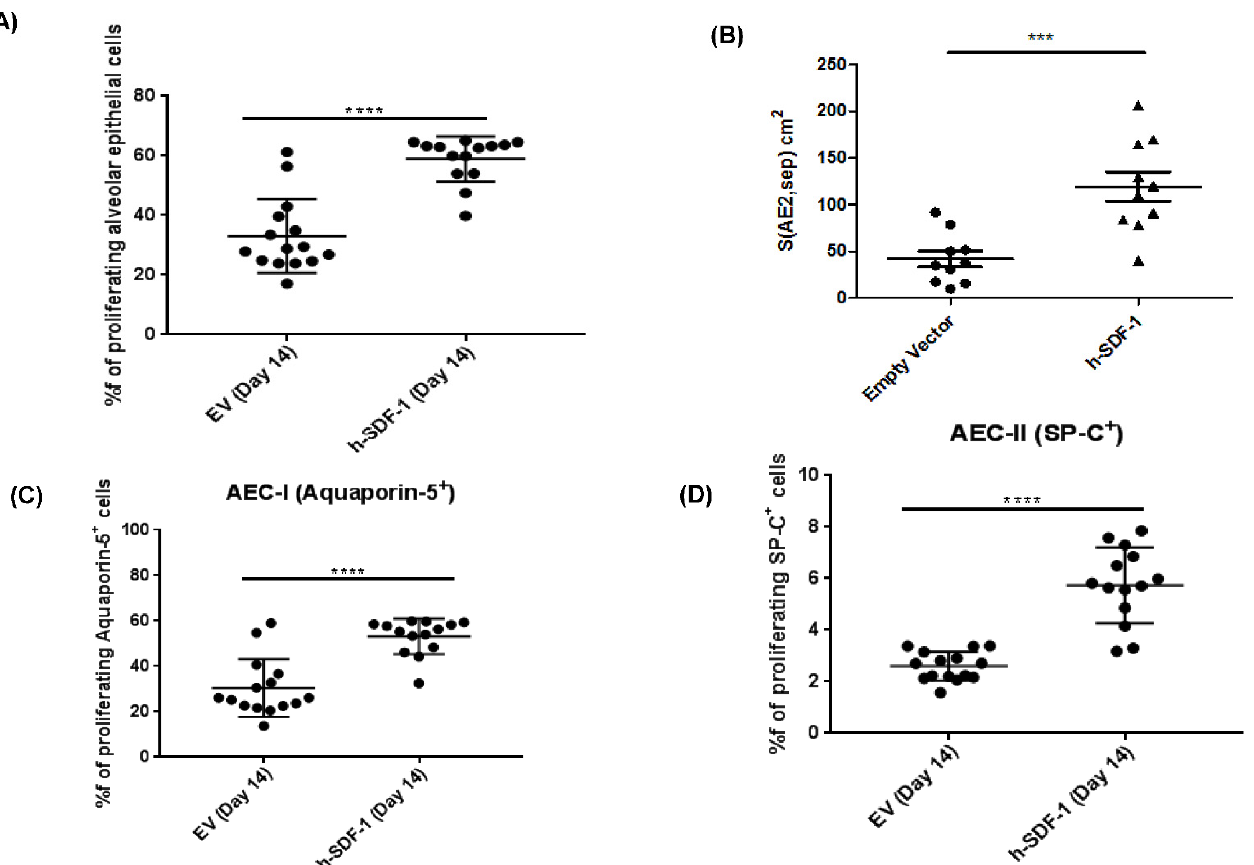
Figure 6. h-SDF-1 overexpression induces AEC proliferation. Compared to the control, pSDF-1 gene transfer to bleomycin-injured rat lung increases proliferation of alveolar epithelial cells (AEC). Flow cytometry data revealed an increased percentage of total alveolar epithelial cells; ( A ) furthermore, the percentage of proliferating AEC type I ( C ) and proliferating AEC II ( D ) were also increased. Moreover, the total septal surface area, defined by the epithelial basal lamina, and covered with AEC2 cells was significantly increased ( D ). ( n = 15) (Mean ± SD; ****: p < 0.0001, ***: p < 0.001). (1 animal in h-SDF-1 group died ( n = 14)). ( n = 10) for stereological analysis ( B ).